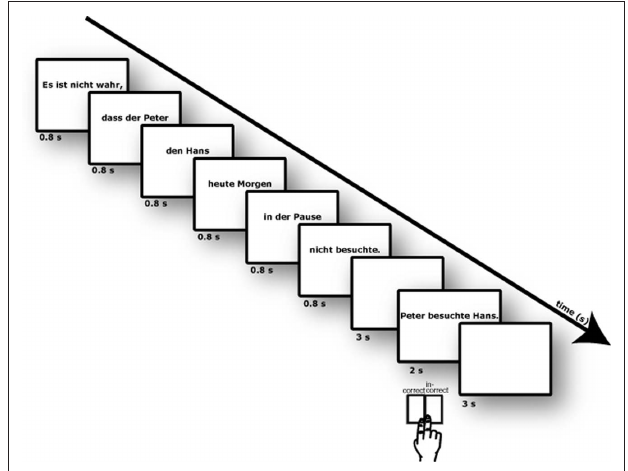
FIguRE 1 | Illustration of experimental design. Sentences were presented phrase-by-phrase. After a delay of 3 s a comprehension sentence was shown and participants should judge the correctness of the content of